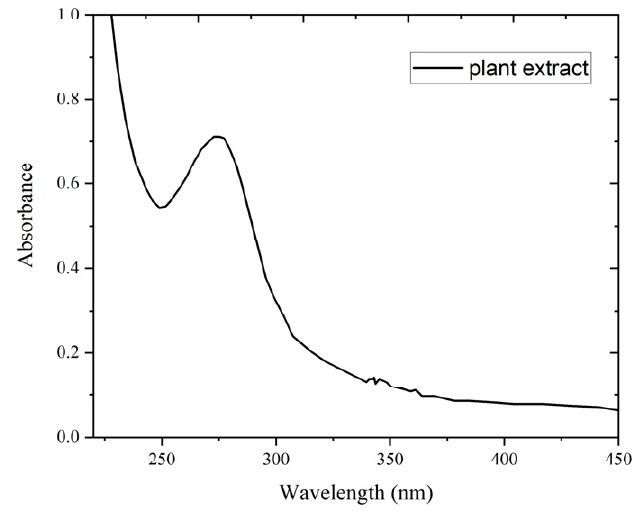
Figure 4. Uv–Vis Leaf Figure 4. Uv – Vis Leaf Extract.